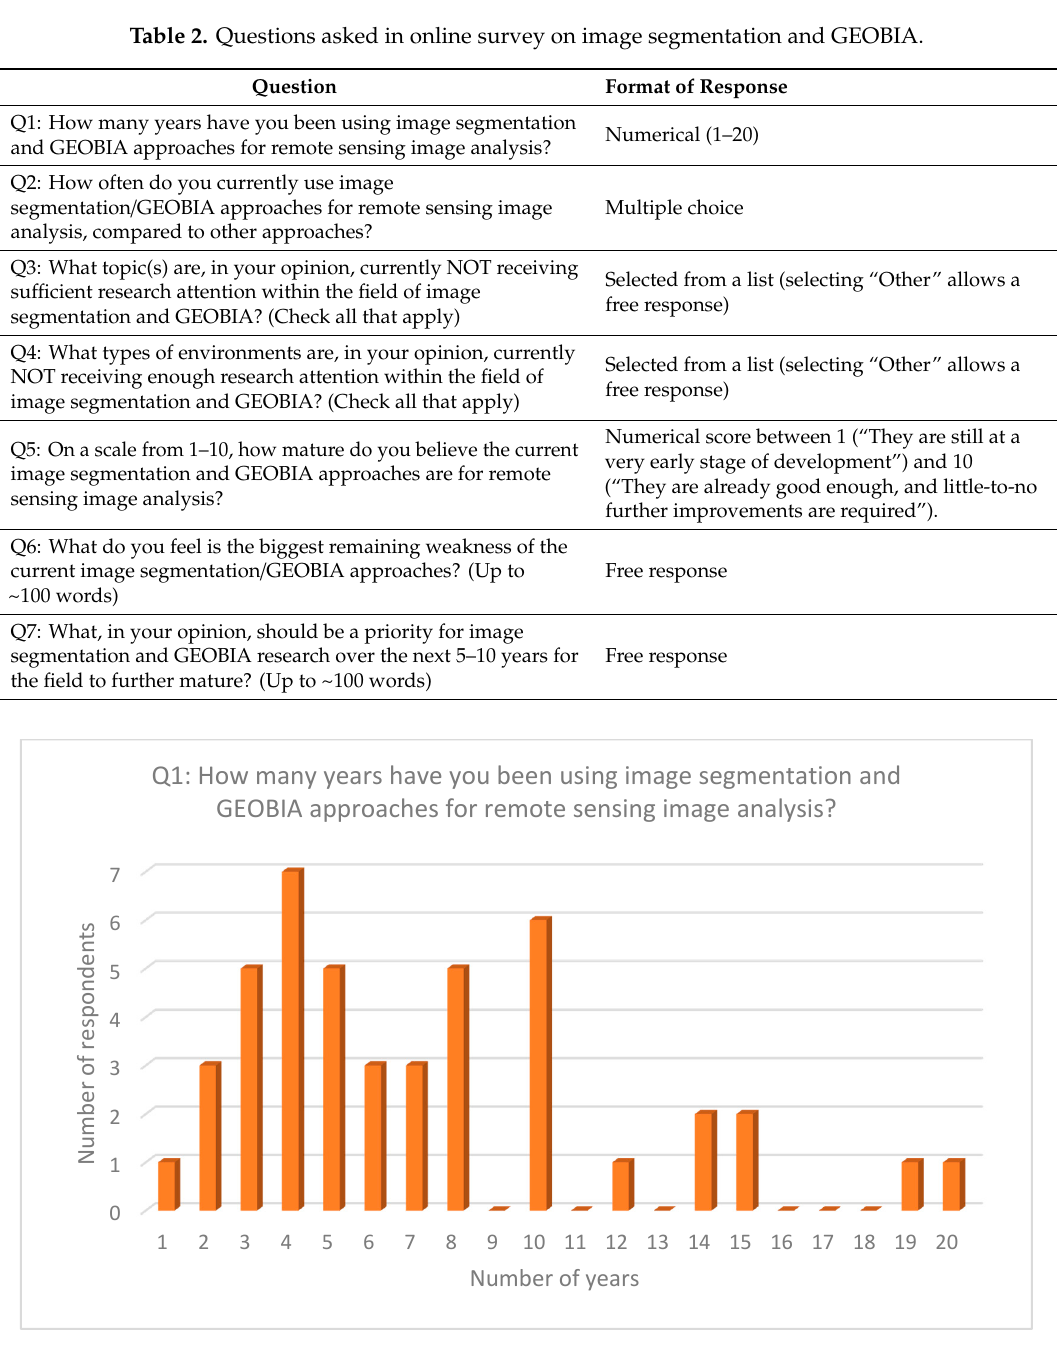
Figure 3. Responses to question 2 (Q2) of the online survey. Among the topics within GEOBIA that were currently not receiving sufficient research attention (Q3), object-based accuracy assessment was the most frequently noted (by 22 respondents), followed by big image data analysis (indicated by 19 respondents), and multi-sensor/multi-temporal data fusion (indicated by 17 respondents) (Figure 4). The latter two topics may be particularly important in the context of the growing archives of free high and moderate spatial resolution satellite data provided by different countries’ space programs. Among the types of environments that were currently not receiving sufficient research attention (Q4), post-disaster areas was the most frequently indicated (by 18 respondents), followed by coastal areas (indicated by 14 respondents) (Figure 5). Interestingly, urban/built-up areas were least frequently indicated for this question, suggesting a potential oversaturation of urban GEOBIA studies. Finally, in response to Q5, the majority of respondents perceived the current image segmentation and GEOBIA approaches as already having received a relatively high level of maturity (i.e., value of 7 or 8 on a scale from 1 (“They are still at a very early stage of development”) to 10 (“They are already good enough, and little-to-no further